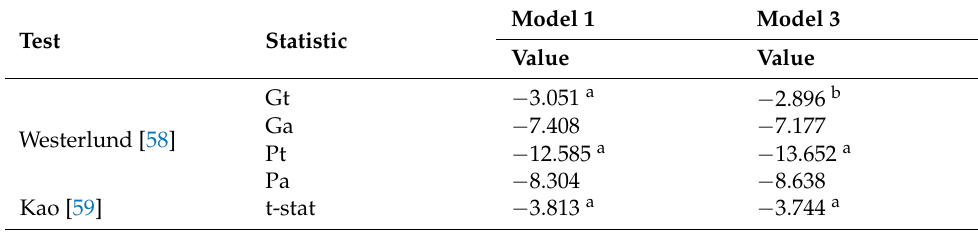
Table 5. Cointegration